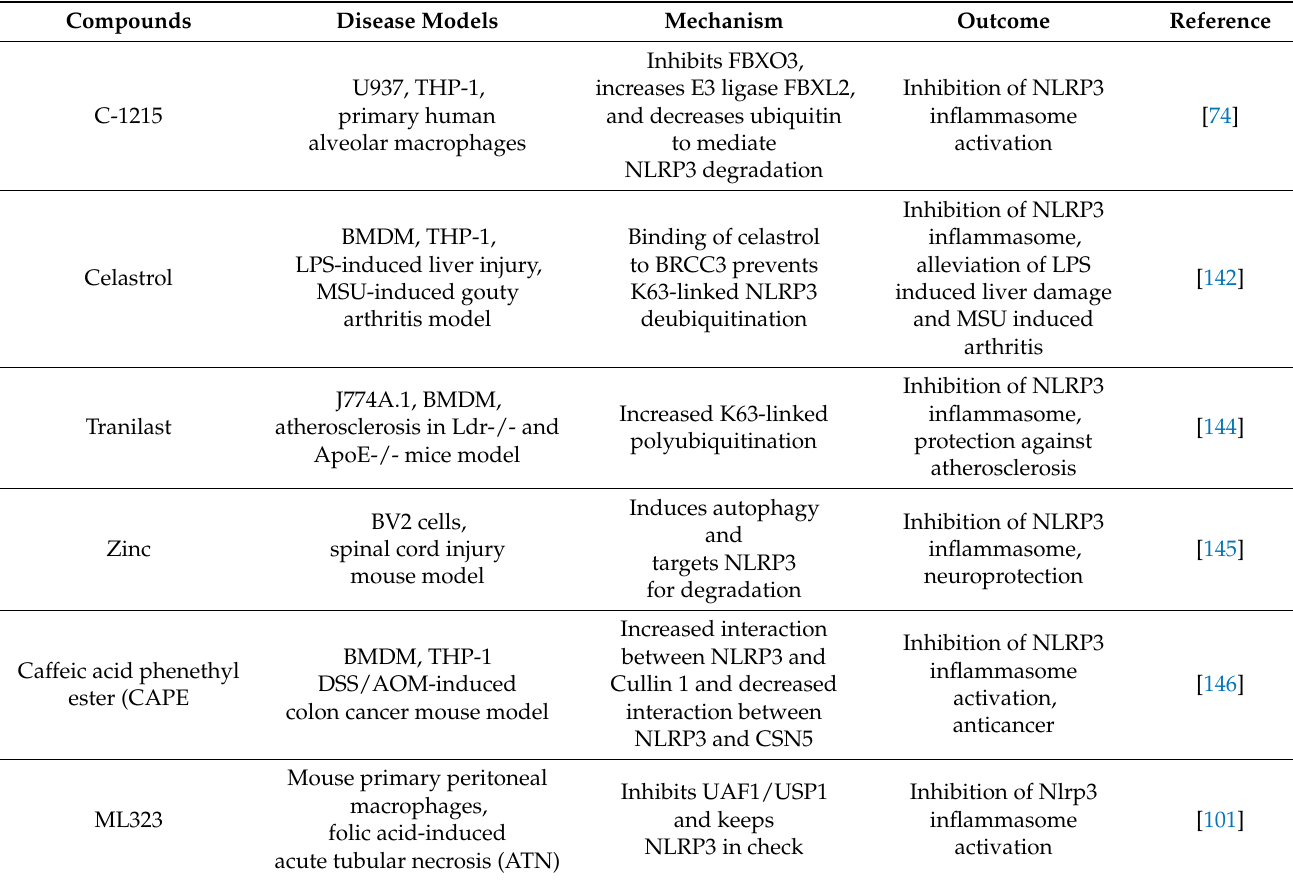
Table 4. NLRP3 ubiquitin-regulating inhibitors of the NLRP3